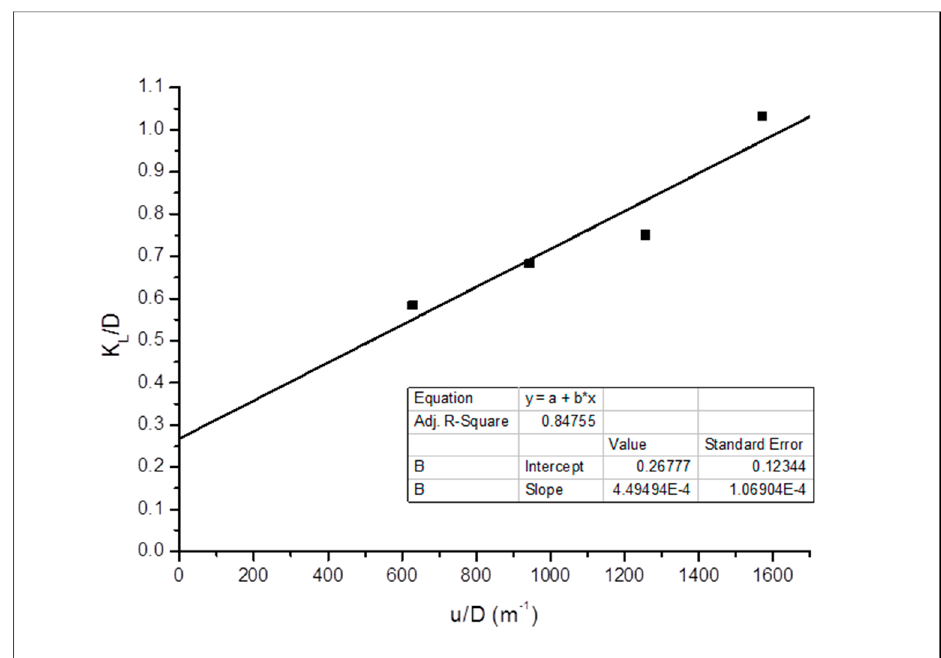
Figure 9. Dispersion to diffusion coefficient ratio against interstitial velocity for Grey Berea (vertical).